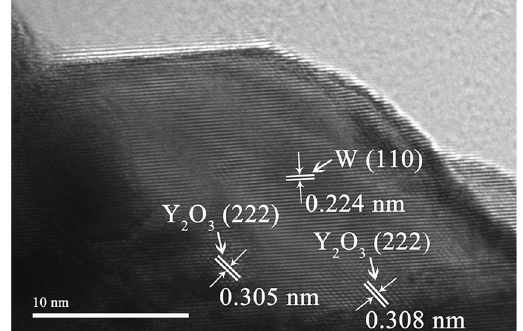
Figure 3. HRTEM image corresponding to a small region in Fig.